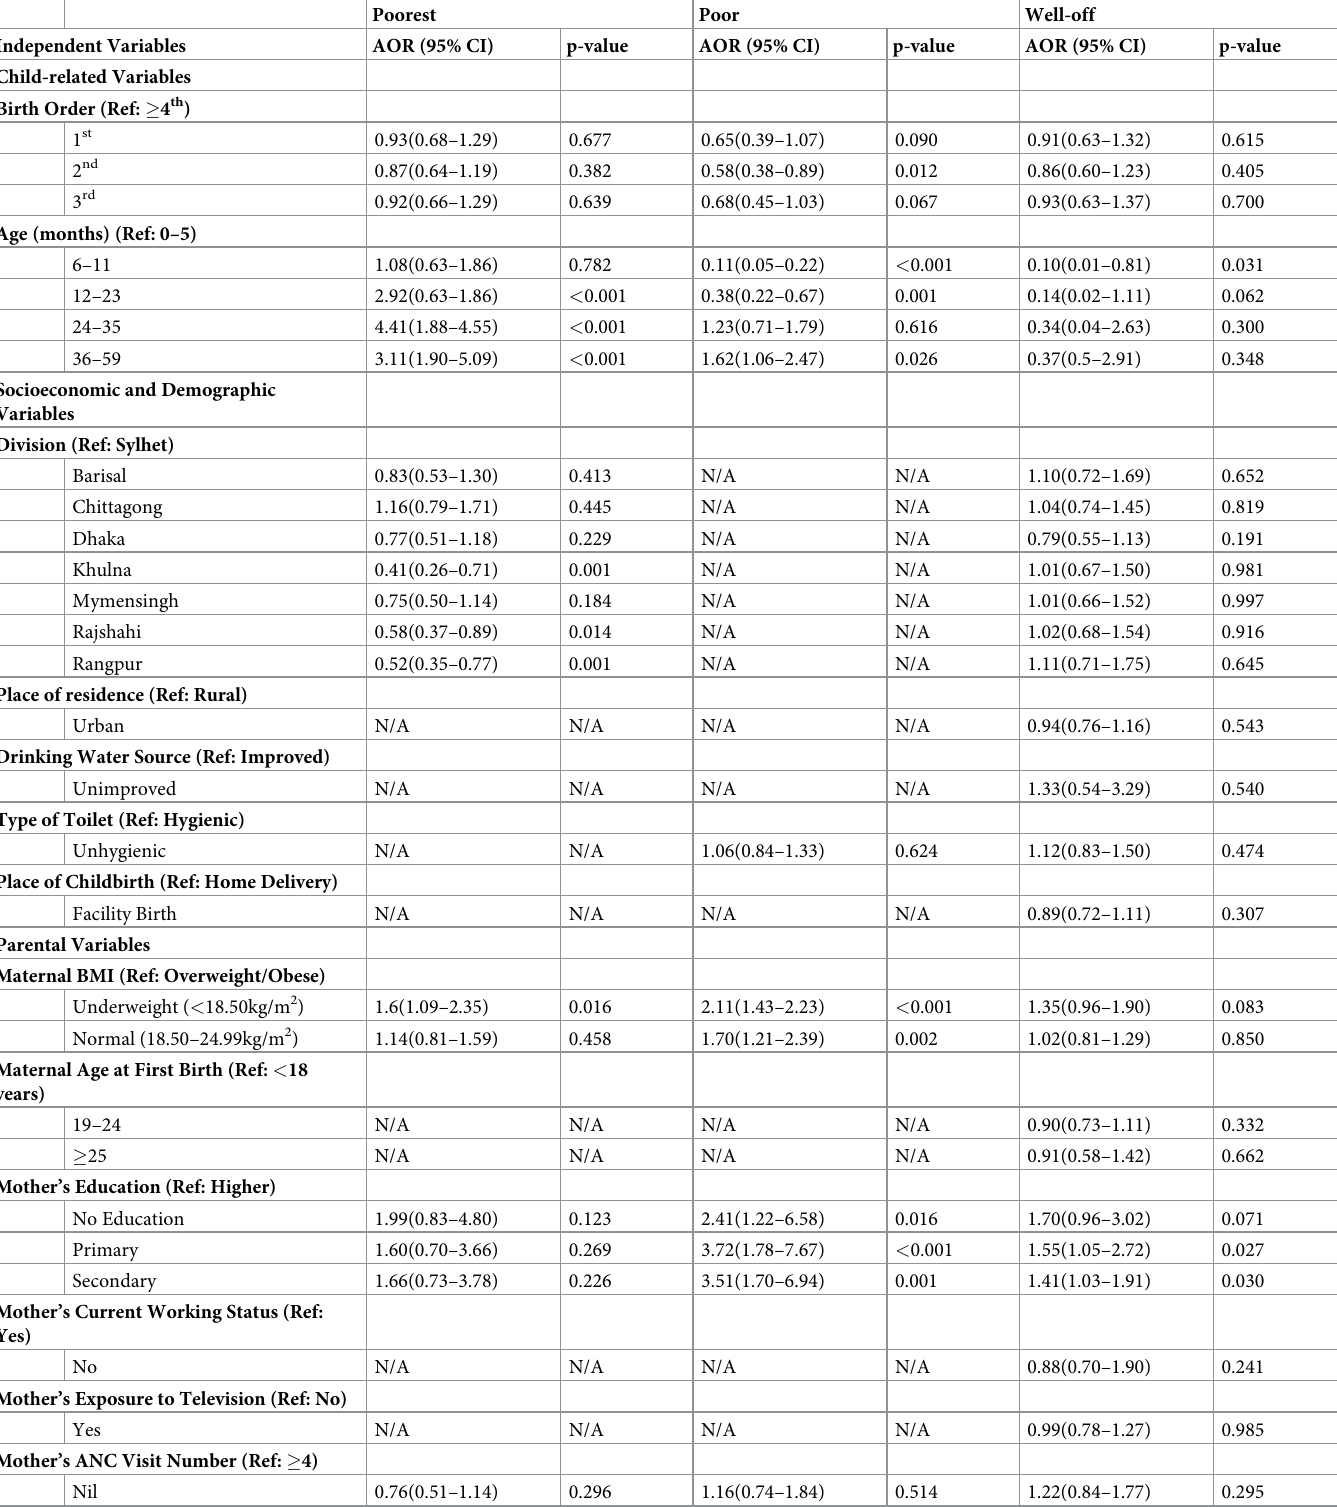
Table 3. Factors associated with stunting within different wealth